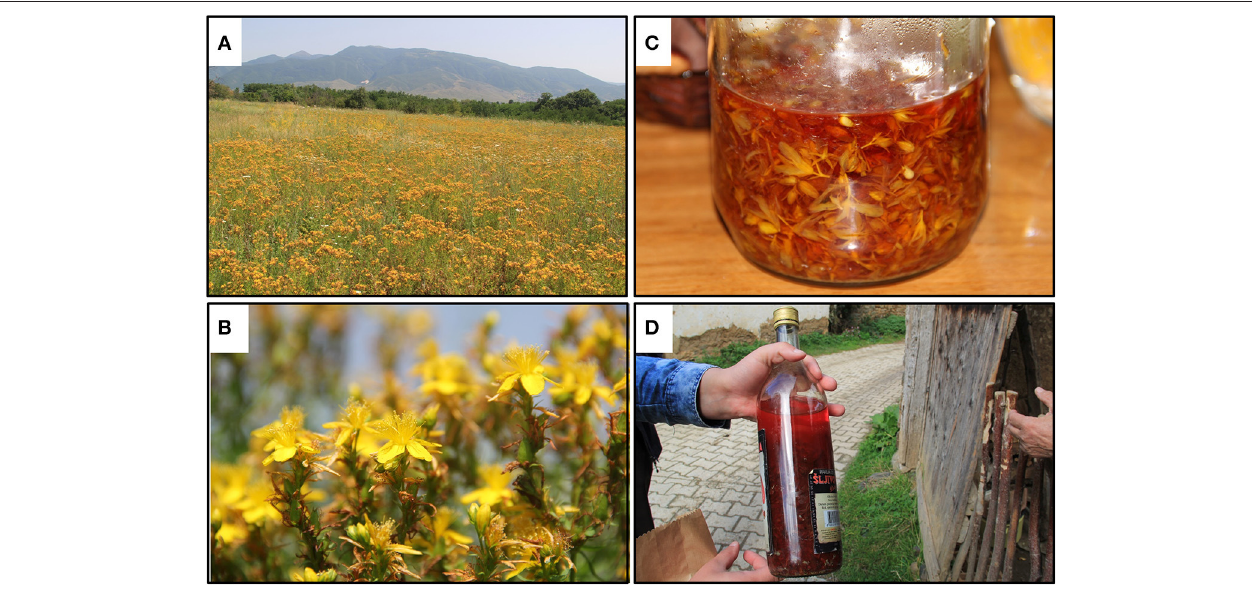
FIGURE 1 | Traditional production of H. perforatum oil macerates for topical applications. (A) Plants are collected from the wild. (B) The flowering aerial parts are harvested. (C) The flowers are covered with oil (typically olive oil or sunflower oil) and exposed to the sun for 40 days. (D) The oil is ready for use once it has passed the sun exposure period and has taken on a blood red